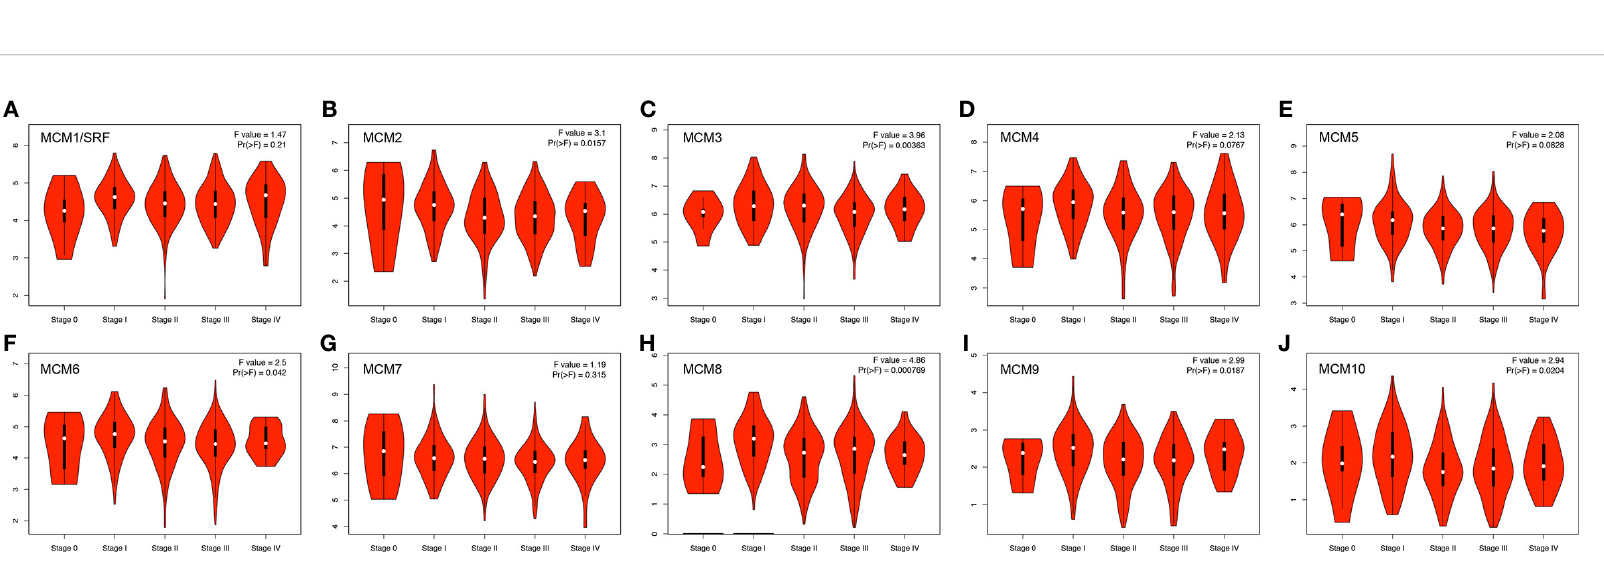
FIGURE 4 | (A – J) Correlation between MCM expression and tumor stage in SKCM patients (GEPIA). MCM2 , MCM3 , MCM6 , MCM8 , MCM9 , and MCM10 groups signi fi cantly varied and associated with the tumor